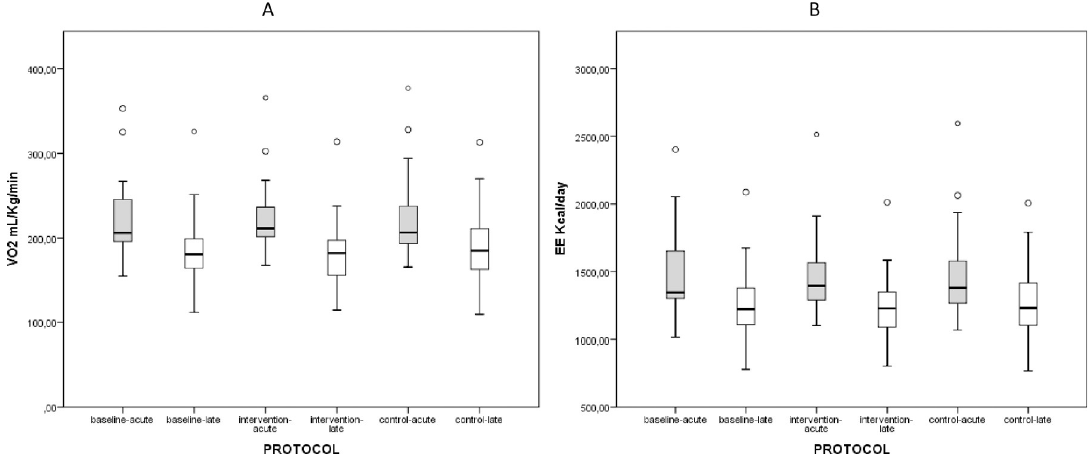
Fig 2. Oxygen consumption and energy expenditure during baseline, intervention, and control protocols in the acute and late phases. A . Oxygen consumption comparison between “septic shock acute phase” and “sepsis and septic shock late phase (p < 0.05). Comparison among baseline, intervention and control protocols (p > 0.05). B . Energy expenditure comparison between “septic shock -acute phase” and “sepsis and septic shock -late phase” (p < 0.05). Comparison among baseline, intervention and control protocols (p > 0.05). Grey boxes- the acute phase. White boxes- the late